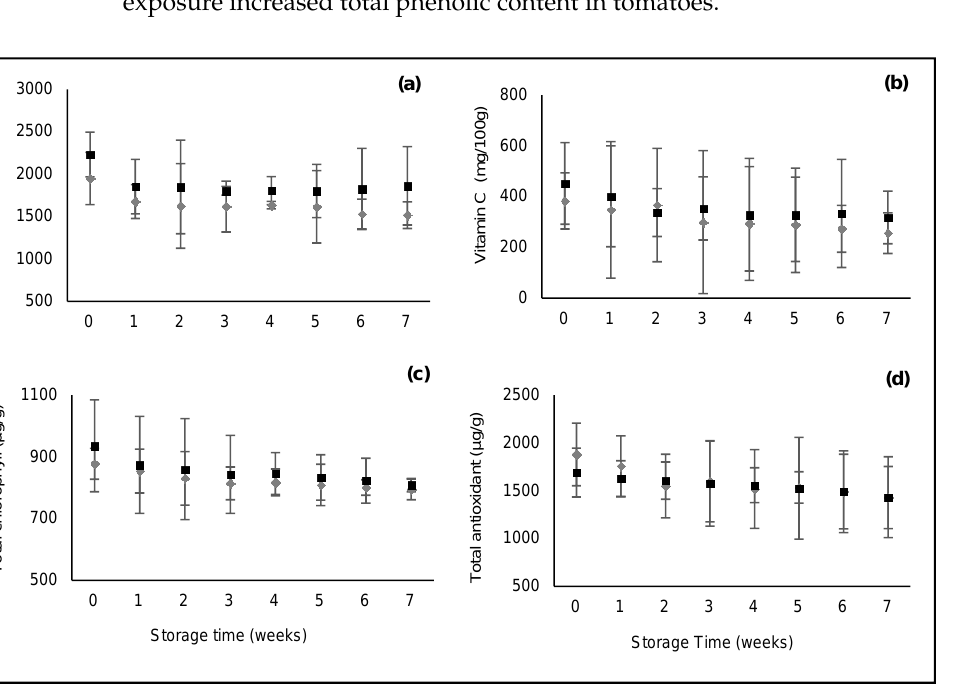
Figure 2. Total phenolic content ( a ) vitamin C, ( b ) total chlorophylls content and ( c ) total antioxidant activity ( d ) in non-ozonized ( ⧫ ) and ozonized ( ◼ ) dried peel. Data represent mean values and bars represent the limits of confidence intervals at 95%.